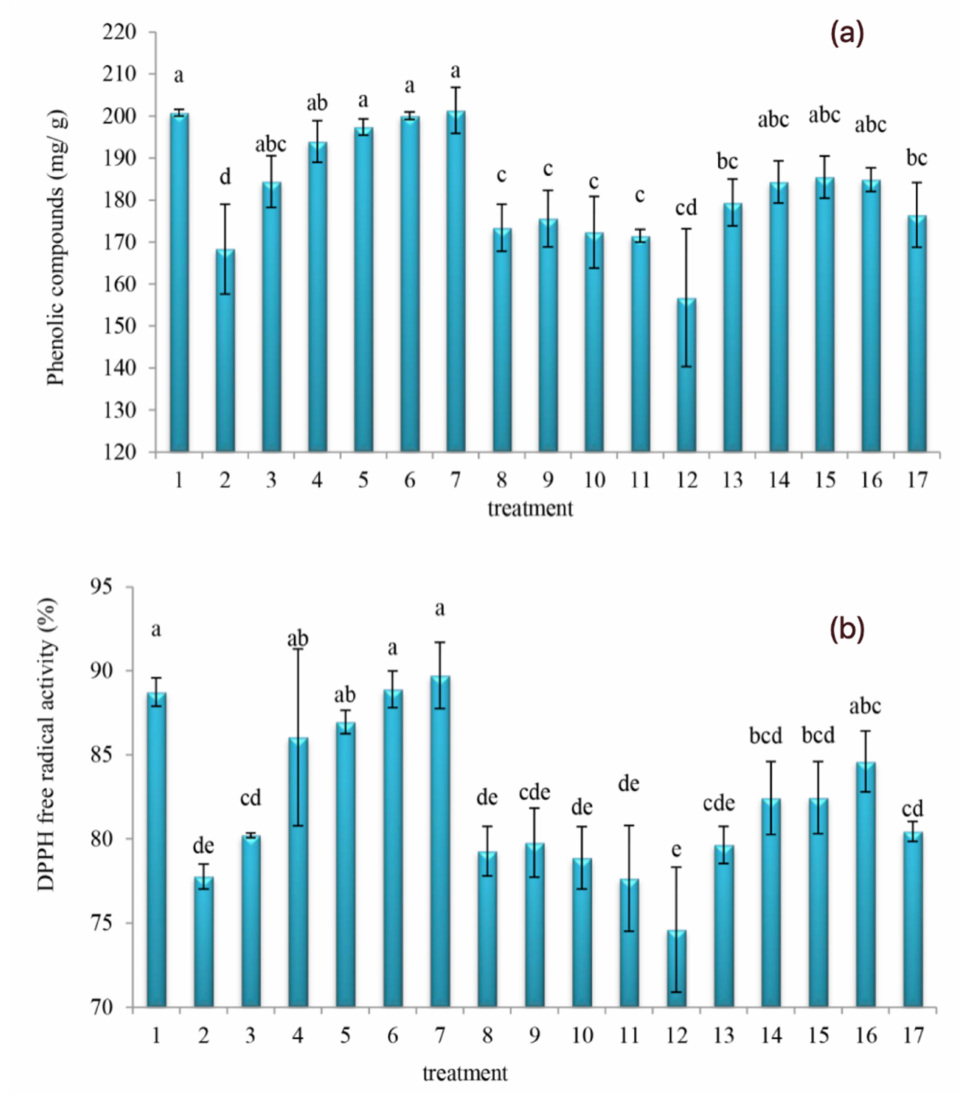
Figure 3. Changes in total phenolic compounds ( a ) and DPPH free radical activity ( b ) values of orange juice subject to different oleaster extracts ((1) control, (2) aqueous extract 5%, (3) aqueous extract 10%, (4) aqueous extract 15%, (5) aqueous extract 20%, (6) aqueous extract 25%, (7) alcoholic extract 5%, (8) alcoholic extract 10%, (9) alcoholic extract 15%, (10) alcoholic extract 20%, (11) alcoholic extract 25%, (12) hydro-alcoholic extract 5%, (13) hydro-alcoholic extract 10%, (14) hydro-alcoholic extract 15%, (15) hydro-alcoholic extract 20%, (16) hydro-alcoholic extract 25%). Different letters (a–e) indicate significant changes occurred at p <